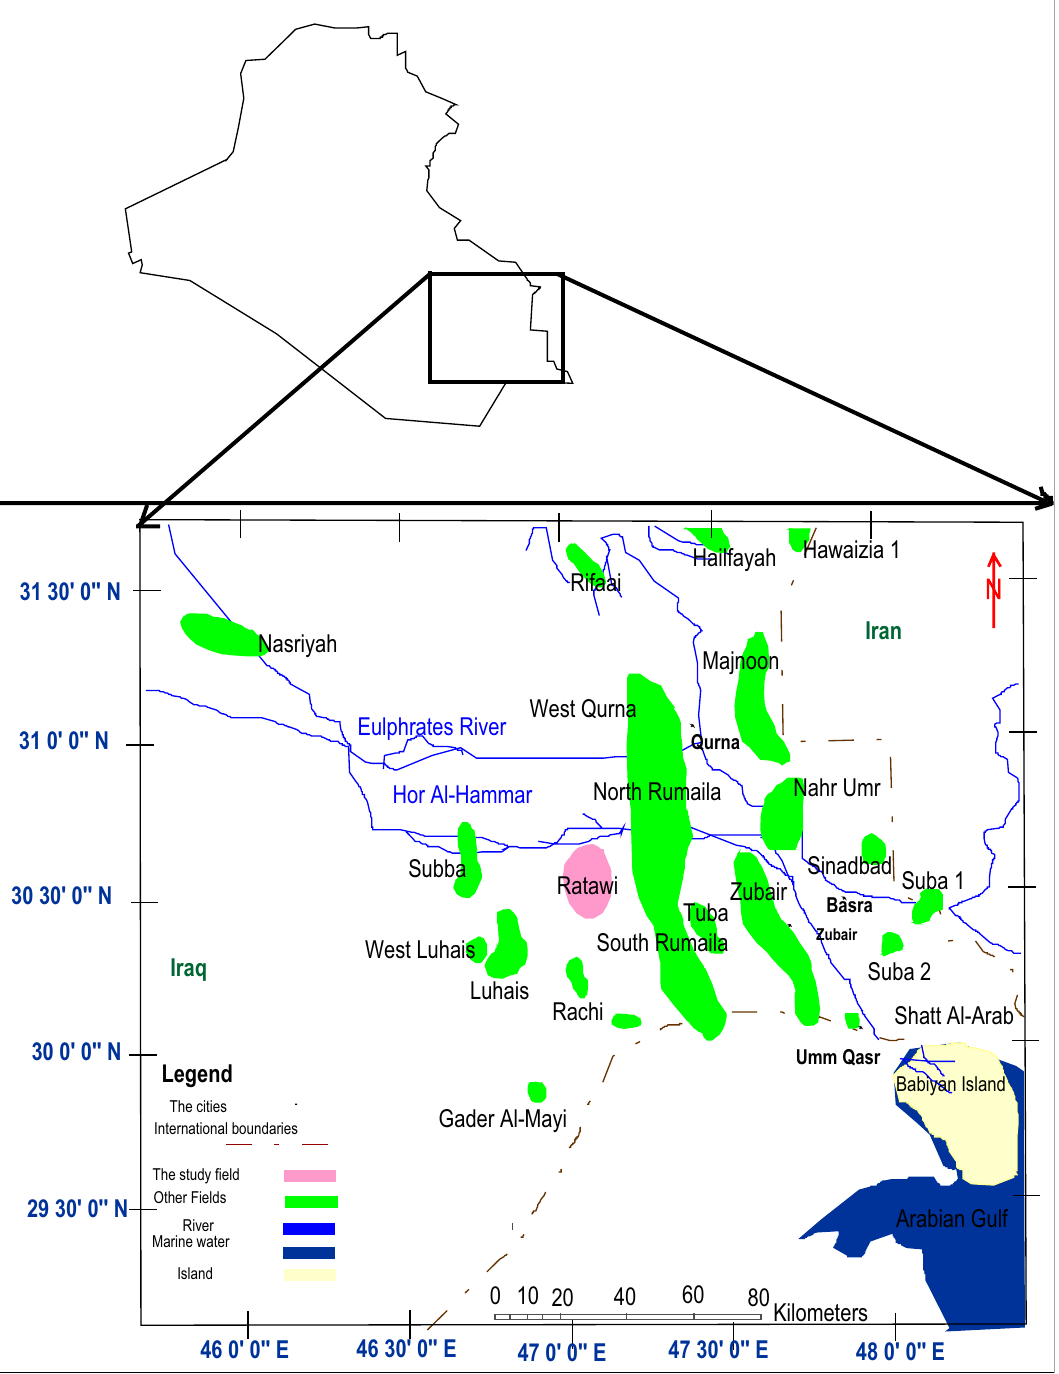
Figure 4. Location map of Ratawi oil field modified from map to Jassim and Goff 1 by using Arc Map 10.3 UTM-WGS 1997, north